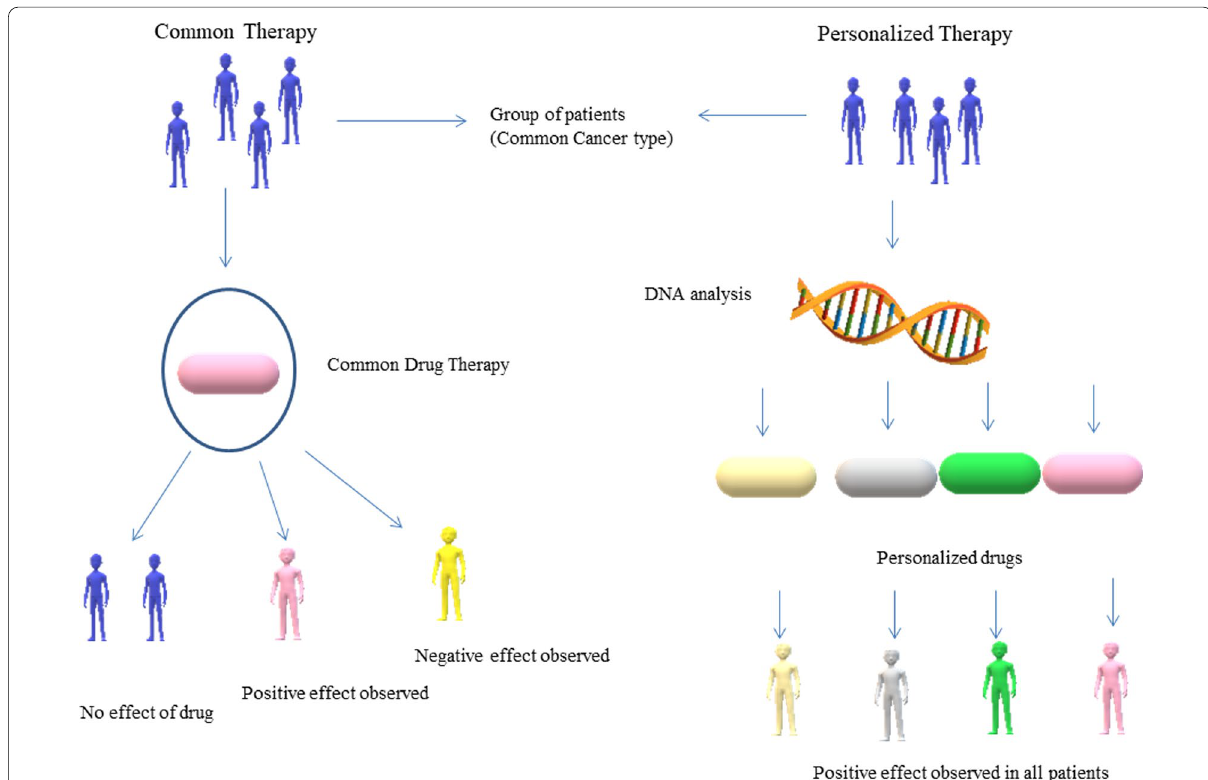
Fig. 4 Comparison between common therapy and personalized therapy: a single drug for a particular disease when administered by a group of people would show highly variable effects. Personalized drugs customized based on genetic analysis and tested on disease models provide a clear effectivity rate of the